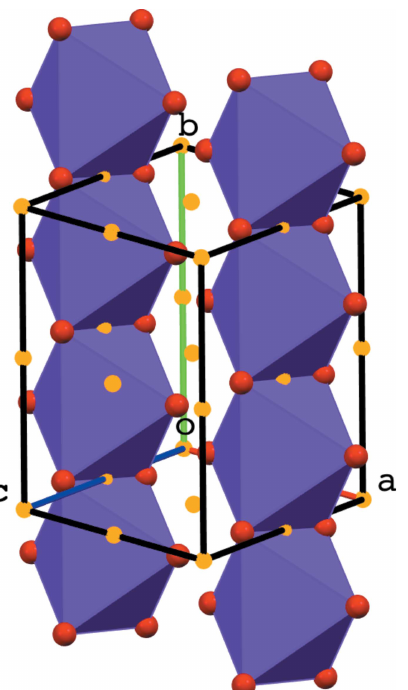
Figure 5 Parallel chains of K—O octahedra running in the [010] direction. Inversion centers are shown as yellow spheres.